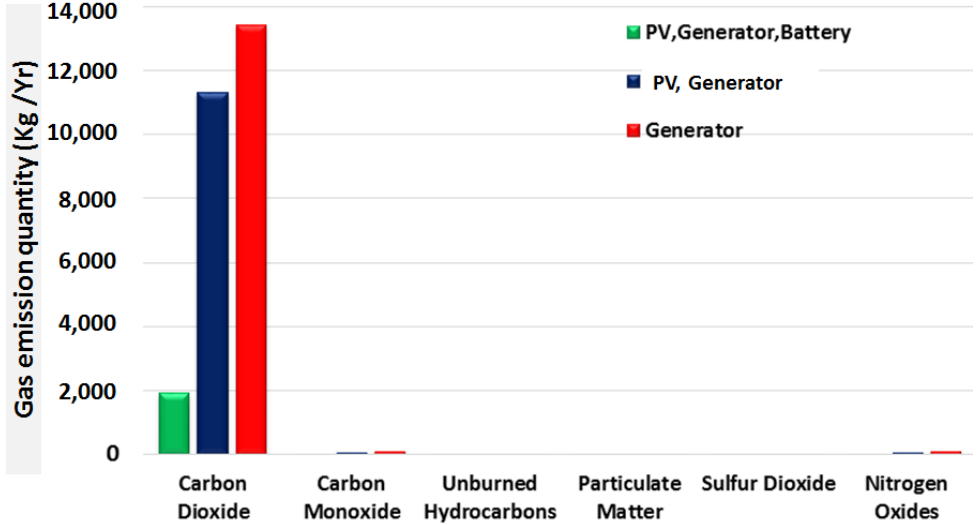
Figure 5. Comparison of gas emissions for different power generation systems for a possible off-grid system.